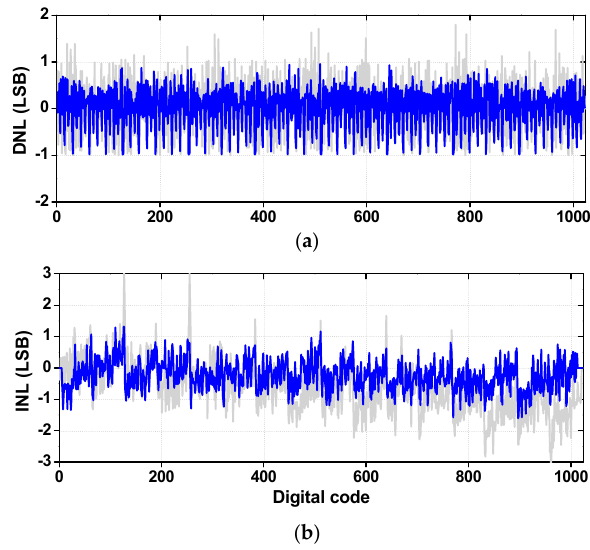
Figure 20. Measured static nonlinearity of ADC. ( a ) differential non-linearity (DNL), ( b ) integral non-linearity (INL).